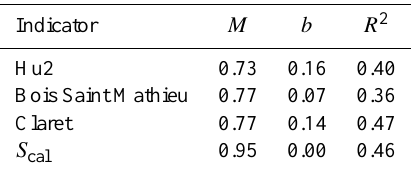
Table 4. α -MFB regression for catchment wetness state indicators. Notation follows that of Table